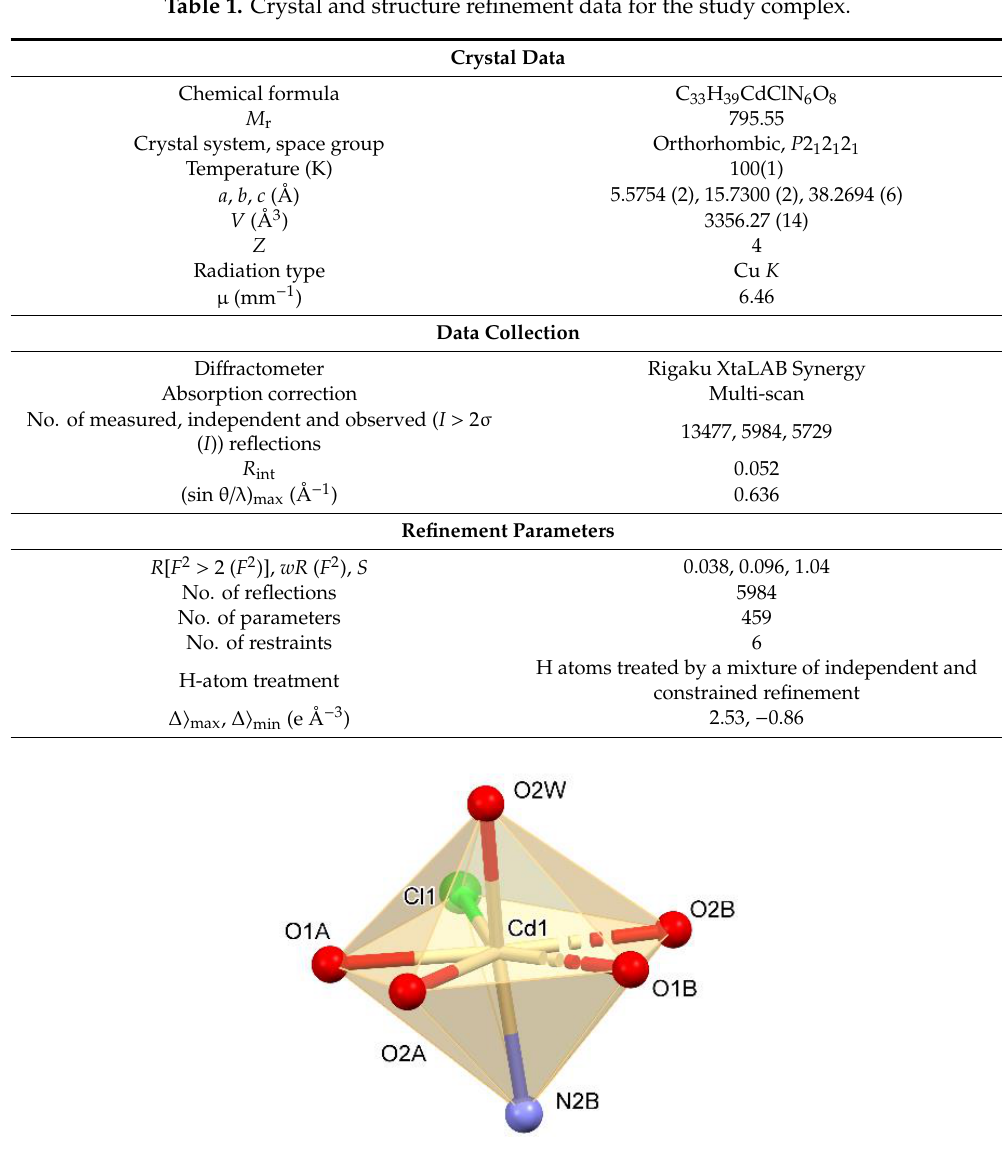
Figure 2. The cadmium coordinate polyhedron.